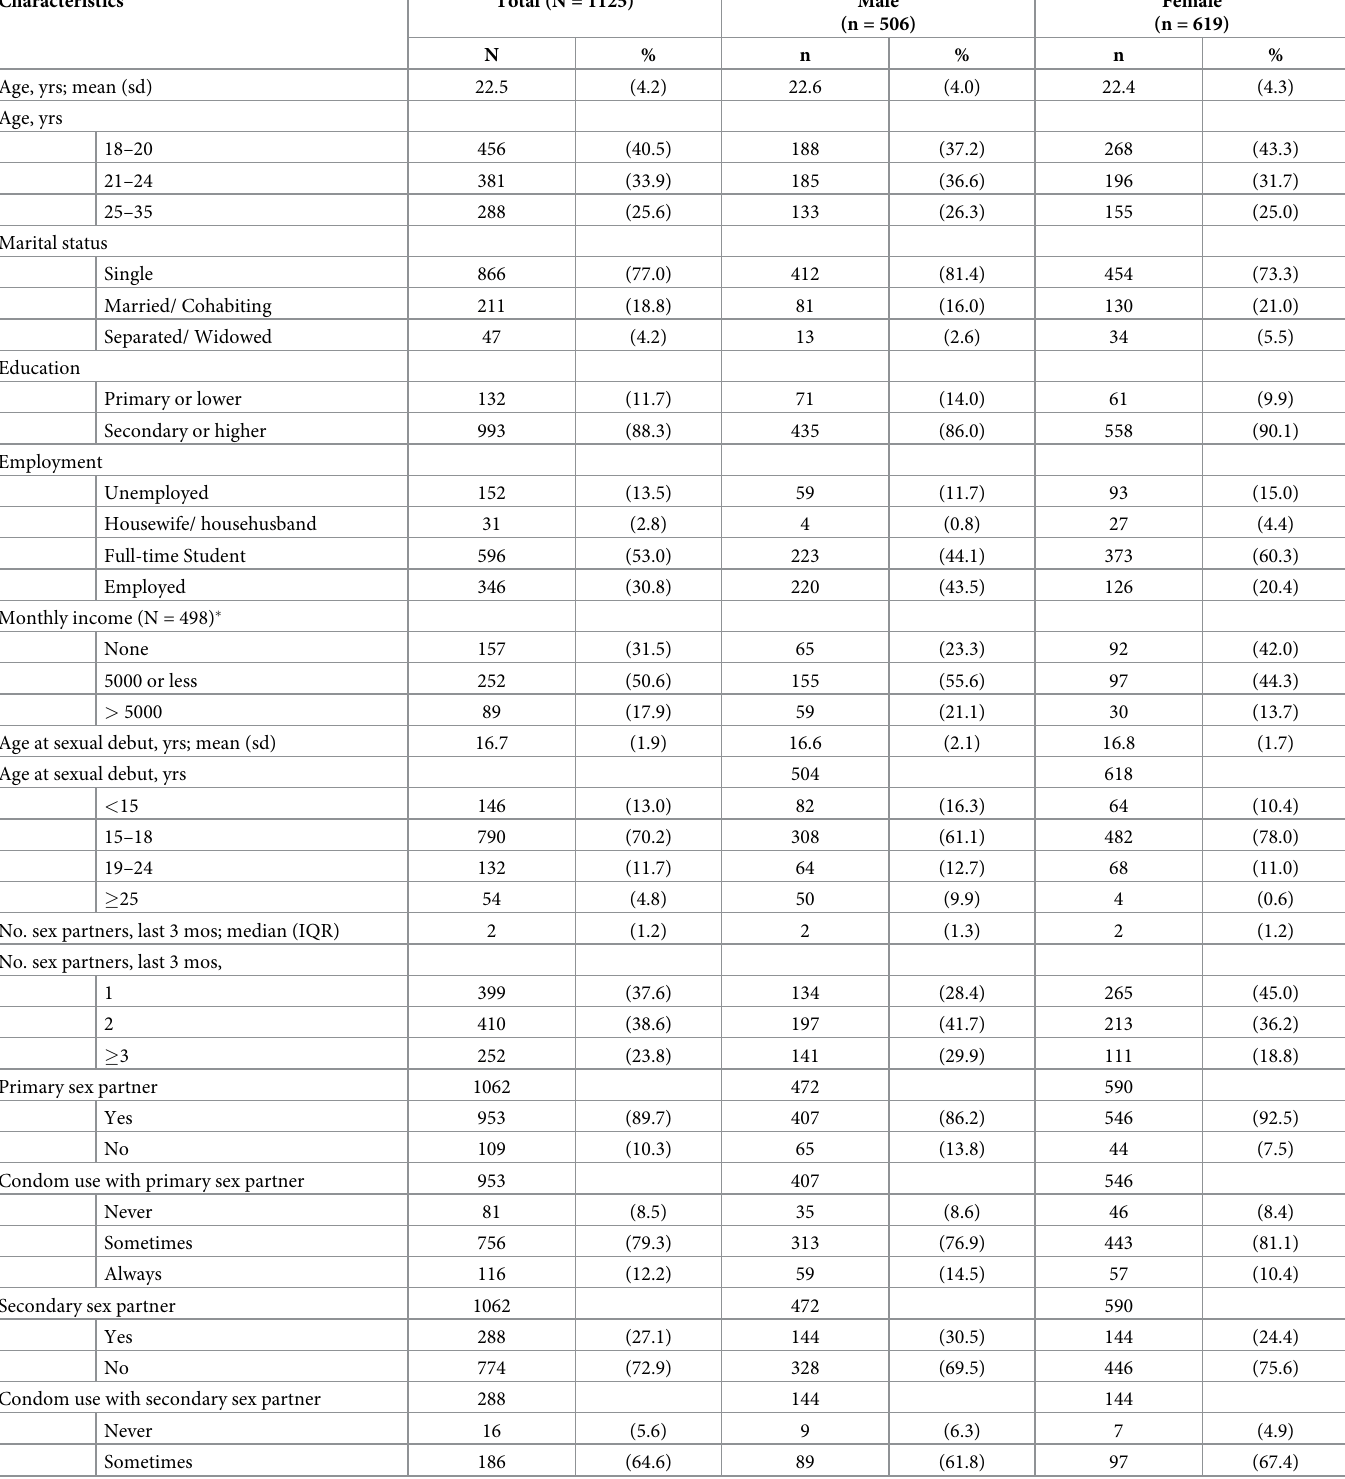
Table 1. Baseline socio-demographic and behavioral characteristics of adults screened from 2013–2014 for enrolment in a vaccine preparedness trial, Maputo city, Mozambique (N = 1125).